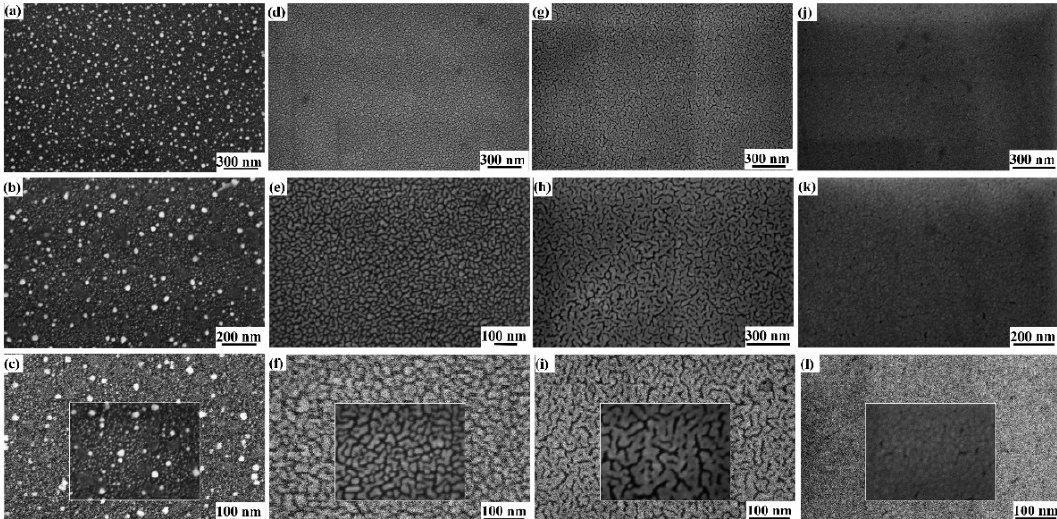
Figure 2. ( a ) A 2 μ × 2 μ m AFM image (three-dimensional reconstruction) of starting bare silicon carbide (SiC) surface. ( b , c ) SEM images of starting bare SiC surface with magnification increasing from ( b ) to ( c ).